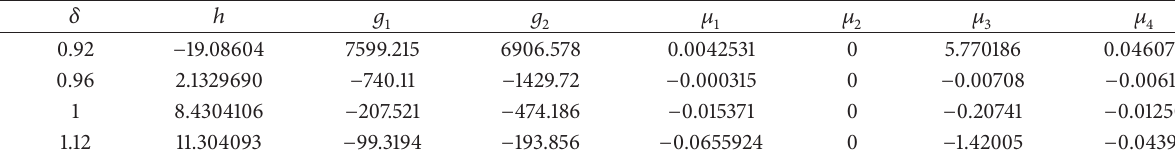
Table 1: Coefficients for different parameter sets.